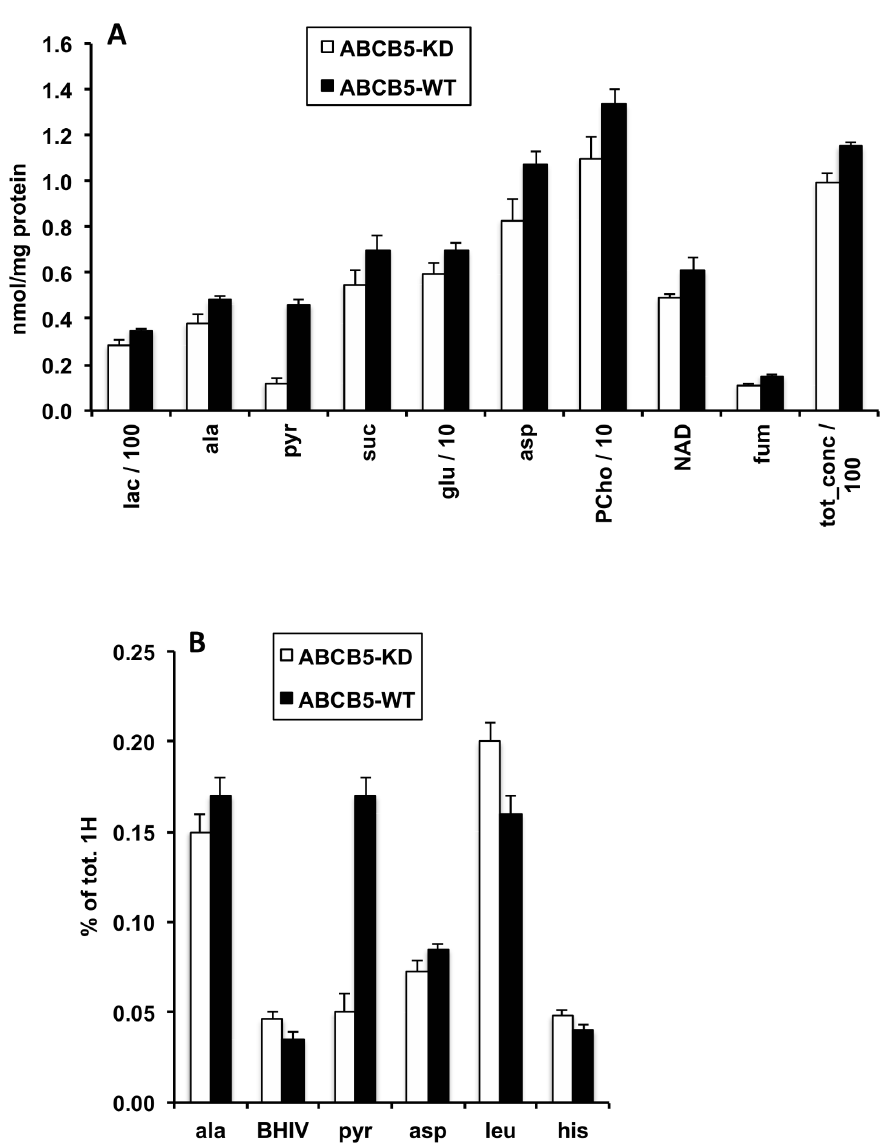
Fig 1. Effects of ABCB5 expression on levels of water-soluble metabolites. Values for human G3361 melanoma cells, measured by 1 H NMR spectroscopy of cell extracts (aqueous phase), are given as means ± SEM, with n = 4 for each group. Open bars, ABCB5-KD cells; full bars, ABCB5-WT cells. Differences between ABCB5-KD and ABCB5-WT cells were significant; detailed statistical results for these metabolites are provided in Table 1. A: Absolute metabolite concentrations, nmol/mg protein. B: Relative metabolite concentrations, % of total 1 H NMR metabolite signals. Abbreviations: lac, lactate; ala, alanine; pyr, pyruvate; suc, succinate; glu, glutamate; asp, aspartate; PCho, phosphorylcholine; NAD, nicotinamide adenine dinucleotide; fum, fumarate; BHIV, β -hydroxy isovalerate; leu; leucine; his, histidine; tot_conc, total concentration of all water-soluble metabolites measured by 1 H NMR